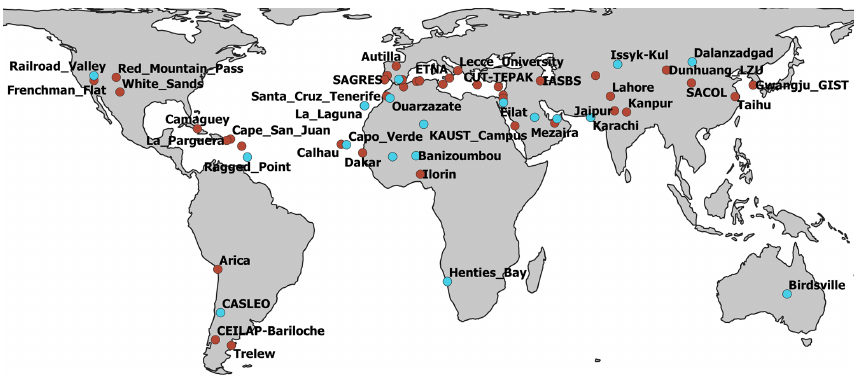
Figure C1. AERONET stations (direct-Sun V3 level 2.0) available in 2012. The station subset used for comparison with MONARCH are shown in turquoise, whereas all other stations are marked in red.